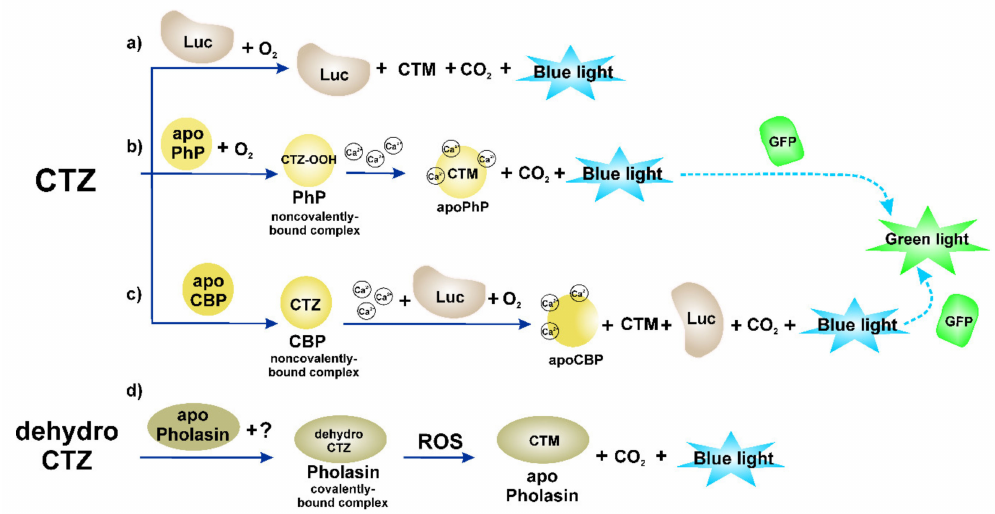
Figure 1. Variety of coelenterazine-dependent bioluminescent systems. ( a – d ) pathways of coelenterazine oxidation with the release of blue light, found in diverse organisms. Luc—luciferase; apoPhP—apophotoprotein; apoCBP—apo-coelenterazine binding protein; CTZ and CTM—coelenterazine and coelenteramide. Explanations are given in the